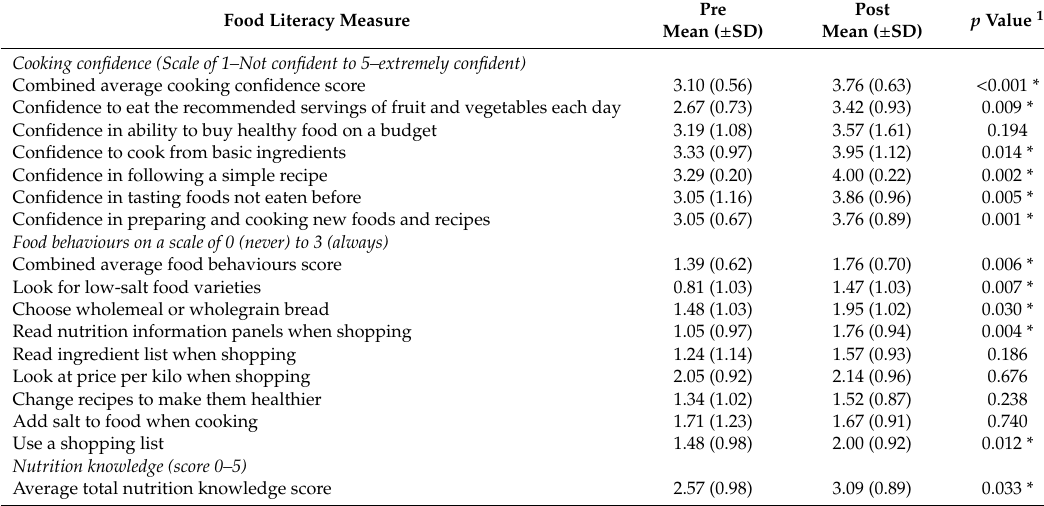
Table 4. Participant’s food literacy ( n =